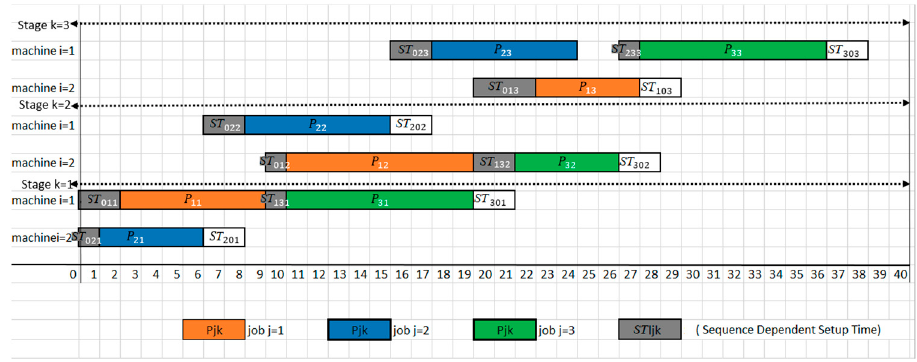
Figure 3. Gantt diagram for the solution of the RFFSP.